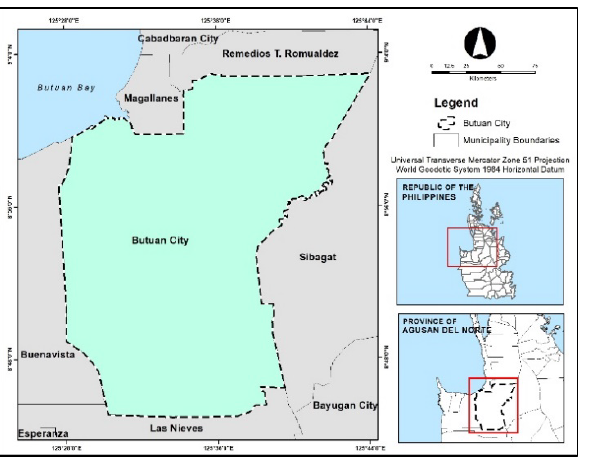
Figure 1 . Map of the Study Area.